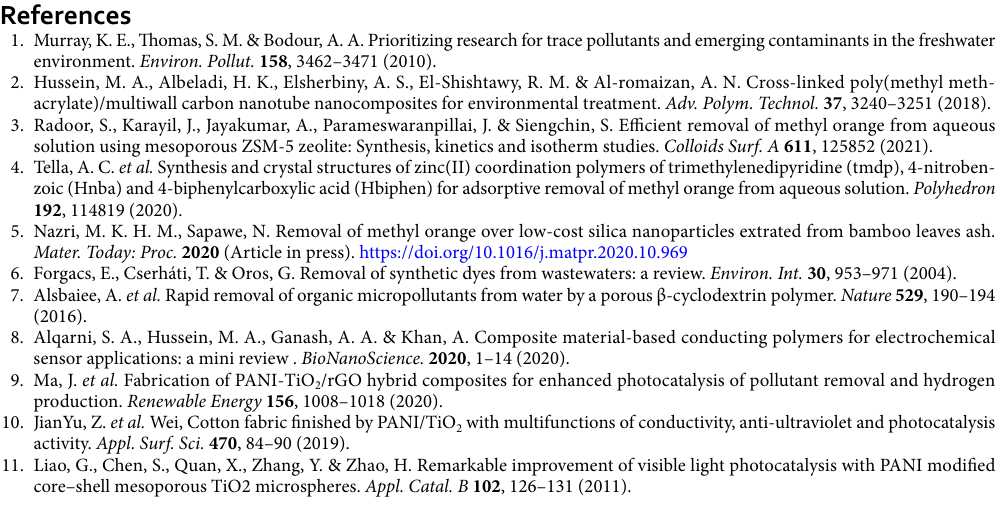
Table 2. Comparable studies of using different adsorbent in methyl orange removal at the optimum conditions.